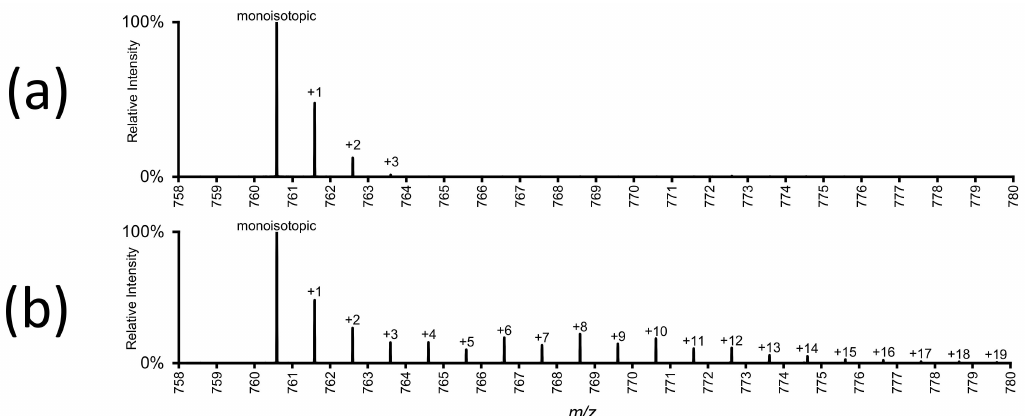
Figure 2. High resolution full-scan mass spectra of a labelled and unlabelled phospholipid. ( a ) PC (phosphatidylcholine) 34:1 from A549 cells grown on non-labelled substrate. The monoisotopic peak at m / z 760.6, as well as three isotopologues, which represent the natural abundance of 13 C, are visible. ( b ) Mass spectrum showing the “isotopic envelope” of the same lipid from cells grown on 13 C 6 -labelled glucose. Varying numbers of 13 C have been incorporated into the lipid via cellular